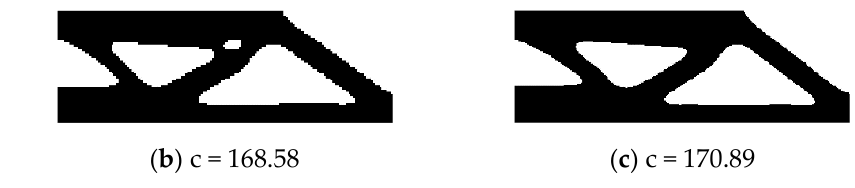
Figure 6. Optimization results with different mesh sizes.